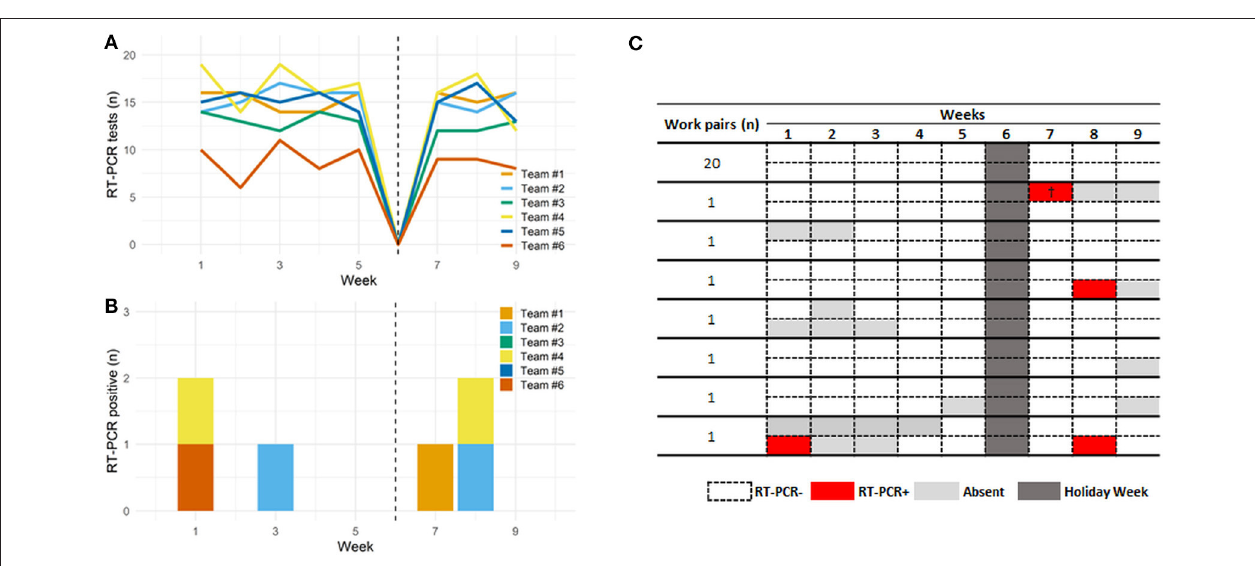
Frontiers in Oral Health |